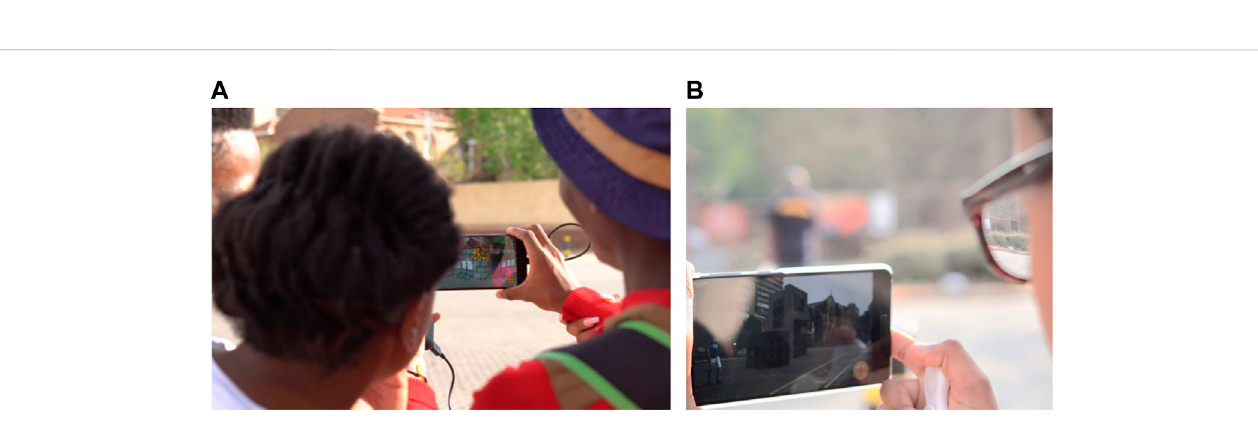
FIGURE 7 Panel (A, B) . Ericsson and UN-Habitat report: “ Mixed reality for public participation in urban and public space design: Towards a new way of crowdsourcing more inclusive smart cities ” . Panel (A) : (Left) Participants in aworkshop view their mindcraft designsin AR.Panel (B) :(Right) The mobile phone view in Minecraft. Reproduced from UN Habitat and Ericsson et al. (2019), with permission from UN Habitat and